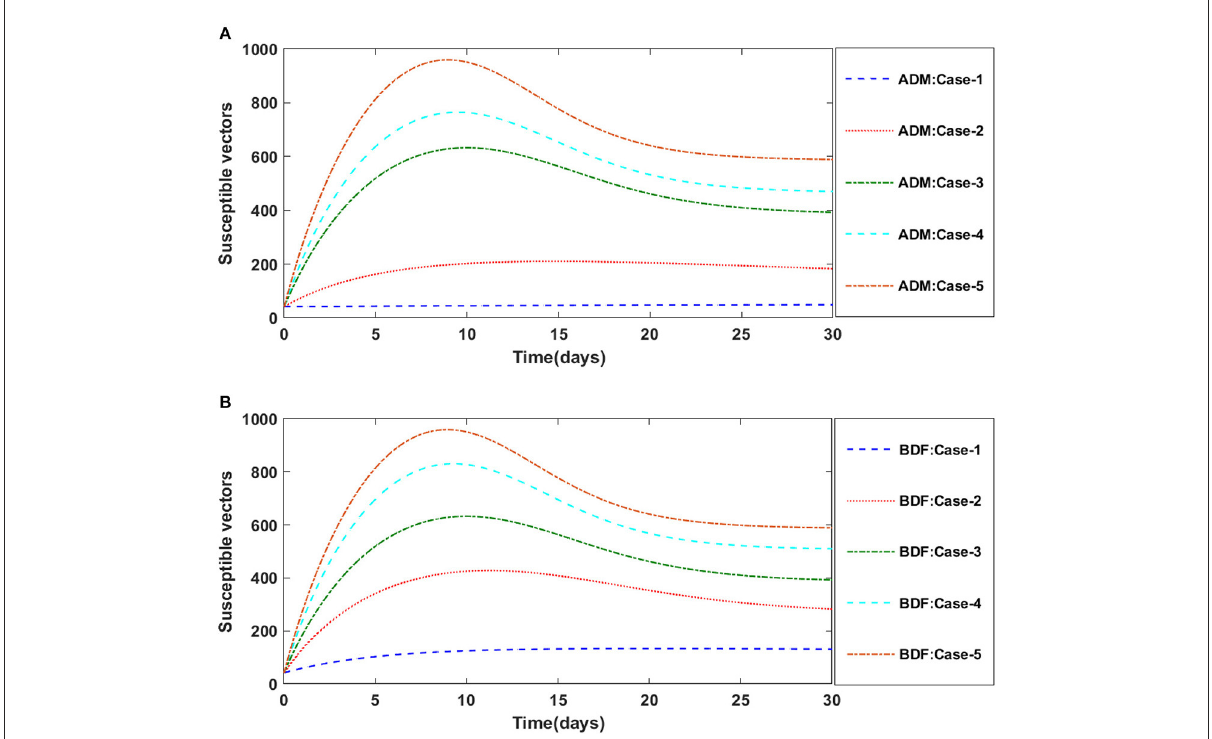
FIGURE20 (A) Dynamics of susceptible vectors for the varition in (cid:127) using ADM for model B1. (B) Dynamics of susceptible vectors for the varition in (cid:127) using BDF for model